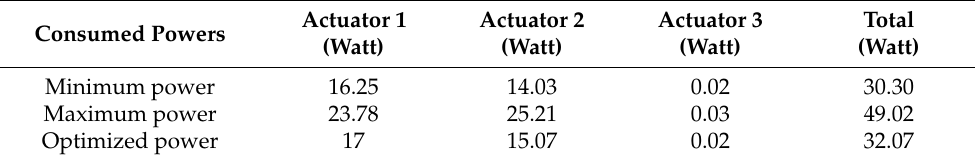
Table 6. Power consumption of three actuators of above-knee prosthesis.